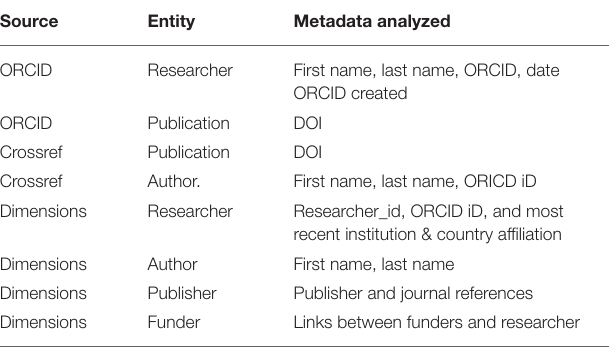
TABLE 1 | Data sources and fields used in the